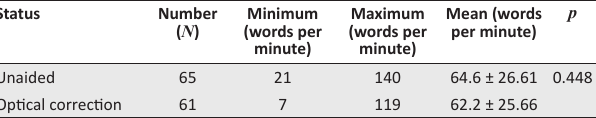
TABLE 5: Minimum, maximum and mean reading rate values obtained without and with optical correction.